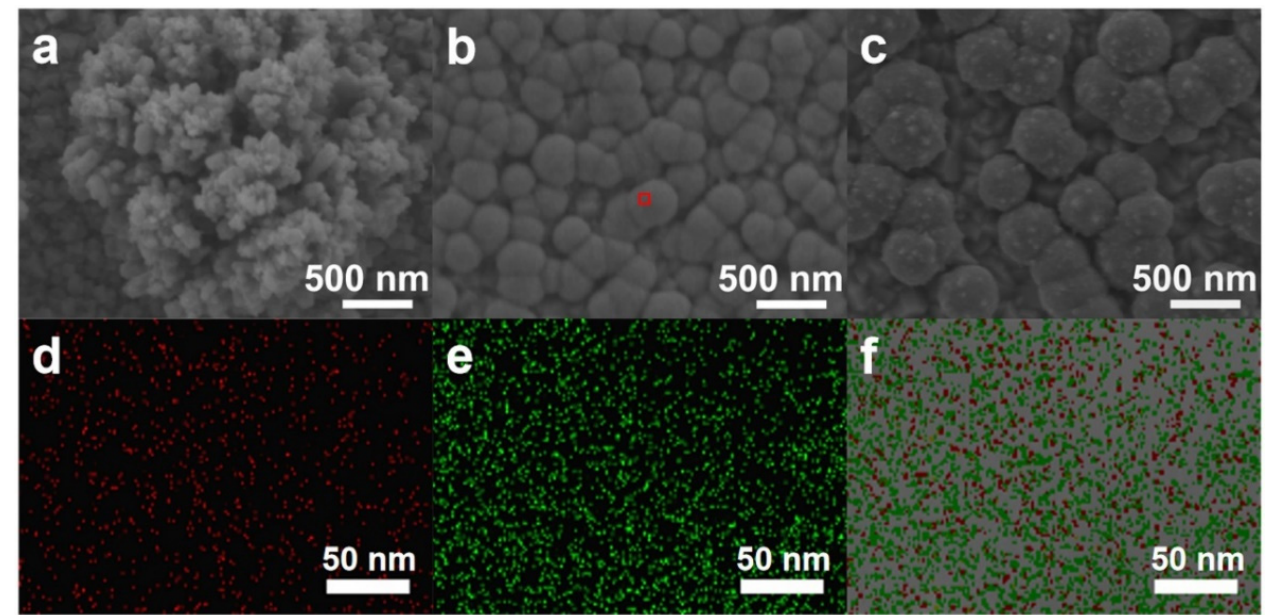
Figure 1. SEM images of the Cu-based electrodes: ( a ) Cu 0 , ( b ) Cu 0.6 , and ( c ) Cu 1.2 . Energy-dispersive spectrometry (EDS) mapping of Cu 0.6 : ( d ) O, ( e ) Cu, and ( f ) O and Cu. The selected range of EDS is from the area circled with red frame in ( b ).